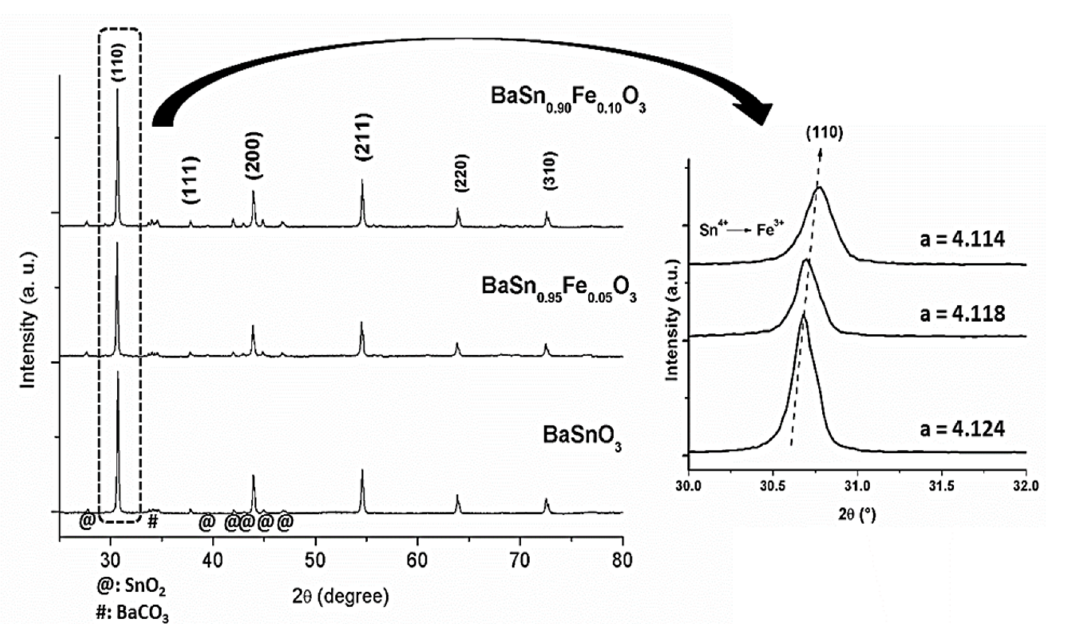
Fe O (0; 0.05 and 0.1 in mol) samples. Detail of the (110) peak in the XRD patterns as a function 1-x x 3